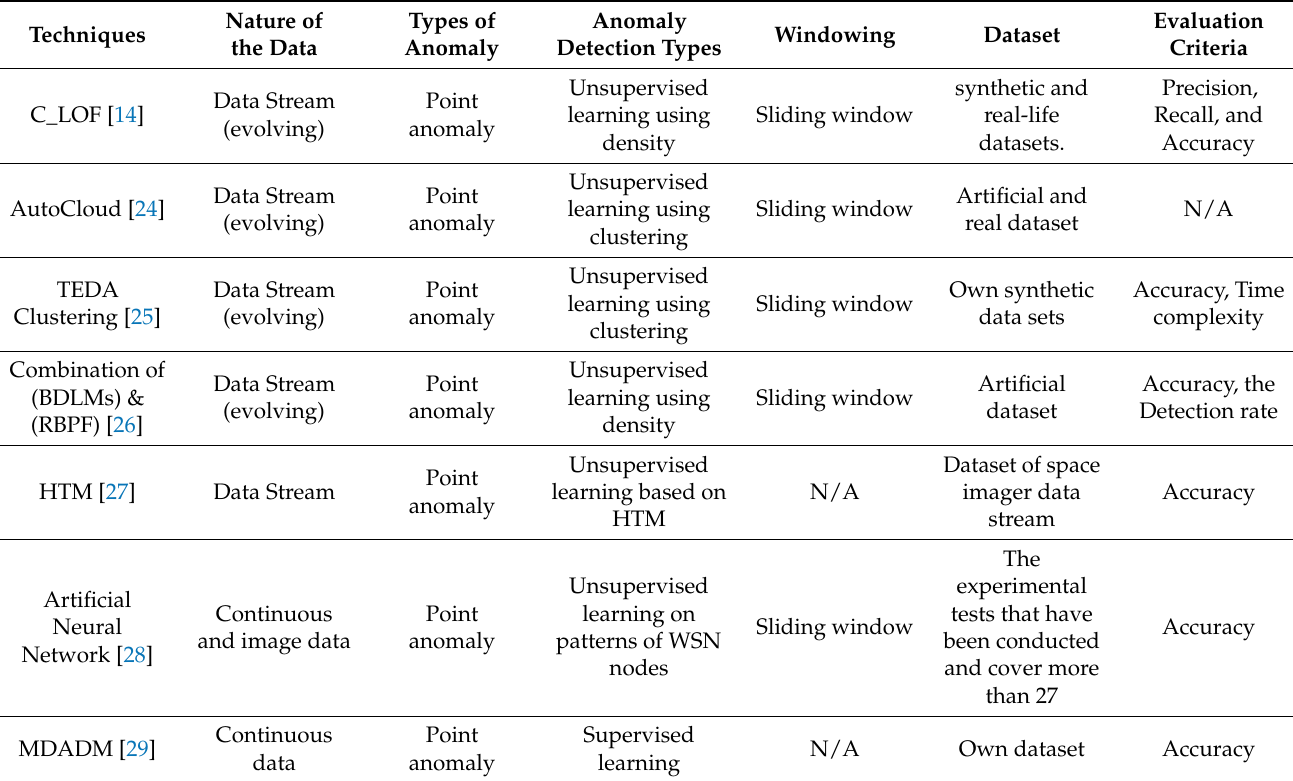
Table 1. Summary of machine learning techniques for data stream anomaly